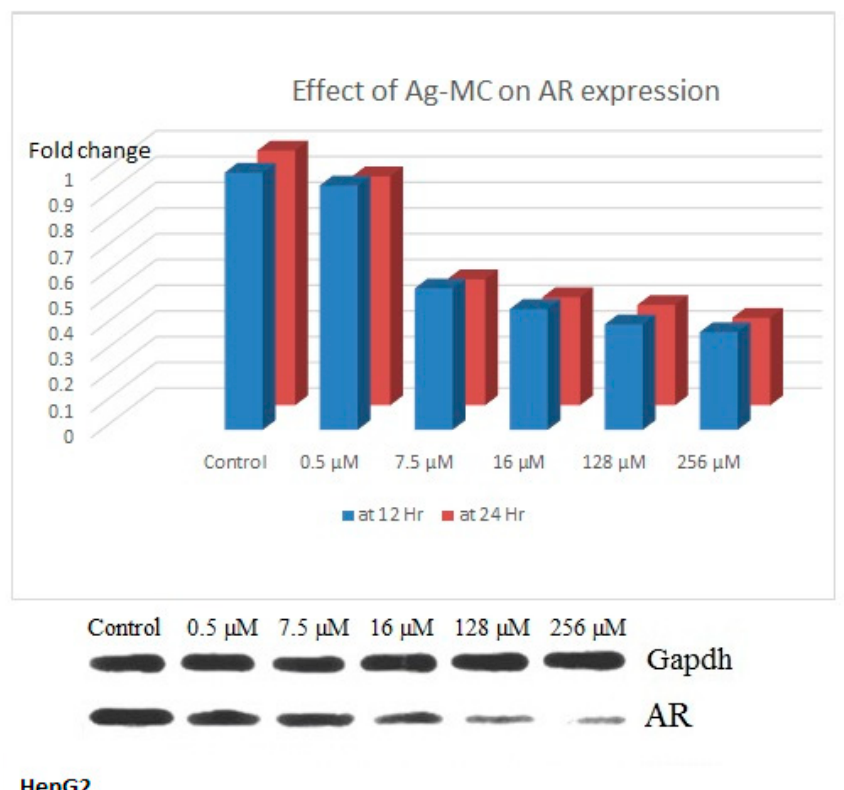
Processes 2019 , 7 , x FOR PEER REVIEW Figure 6. E ff ect of Ag-MC (0.5 µ M to 256 µ M) on AR protein expression. Figure 6. Effect of Ag-MC (0.5 μ M to 256 μ M) on AR mRNA expression (fold changes in qPCR) and AR protein expression in blot.